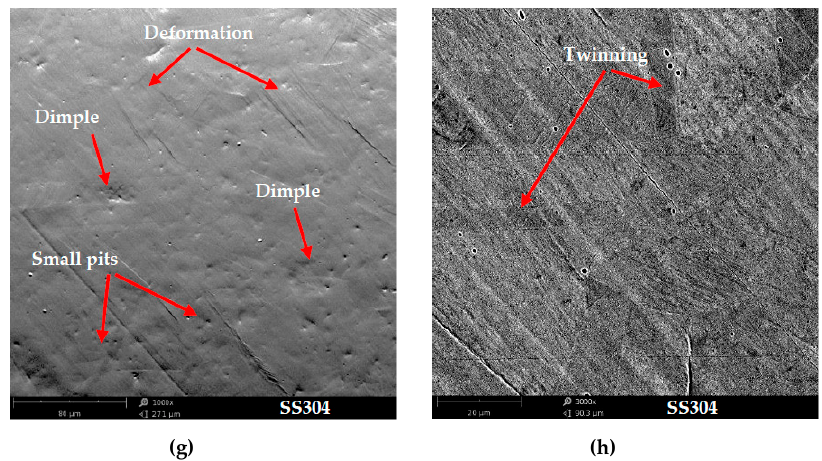
Figure 9. Eroded surface morphology of reference samples after 4 min of exposition to cavitation: ( a , b ) AlCu4; ( c , d ) Cu110; ( e , f ) CuZn40; ( g , h ) SS304. SEM, BSE and topo-modes.